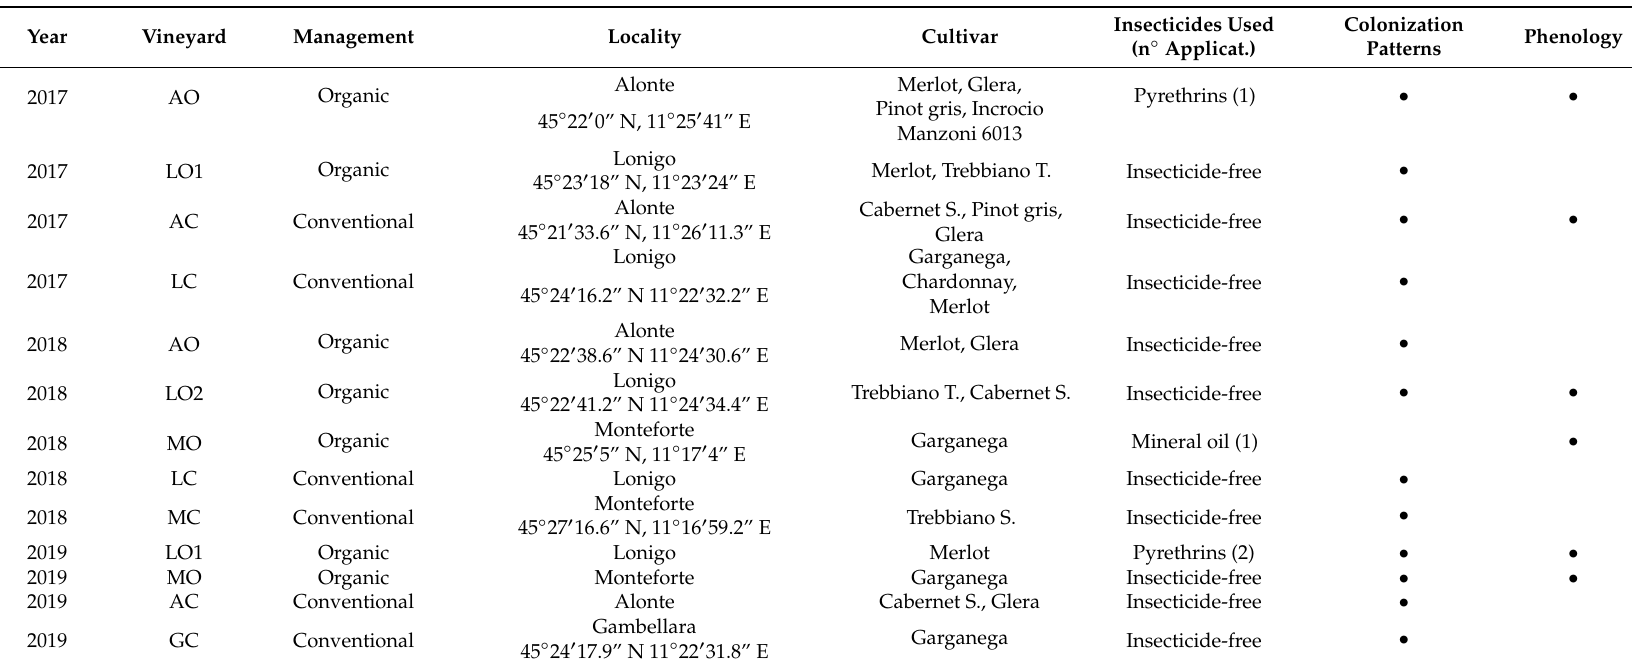
Table 1. Vineyards considered in studies on the colonization patterns and phenology of E. vulnerata . Dots indicate which study was performed in these